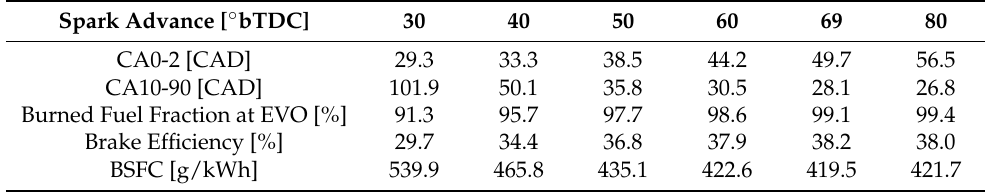
Table 6. Combustion characteristics and engine performance; 1500 rpm, φ = 1, WOT, no boost.